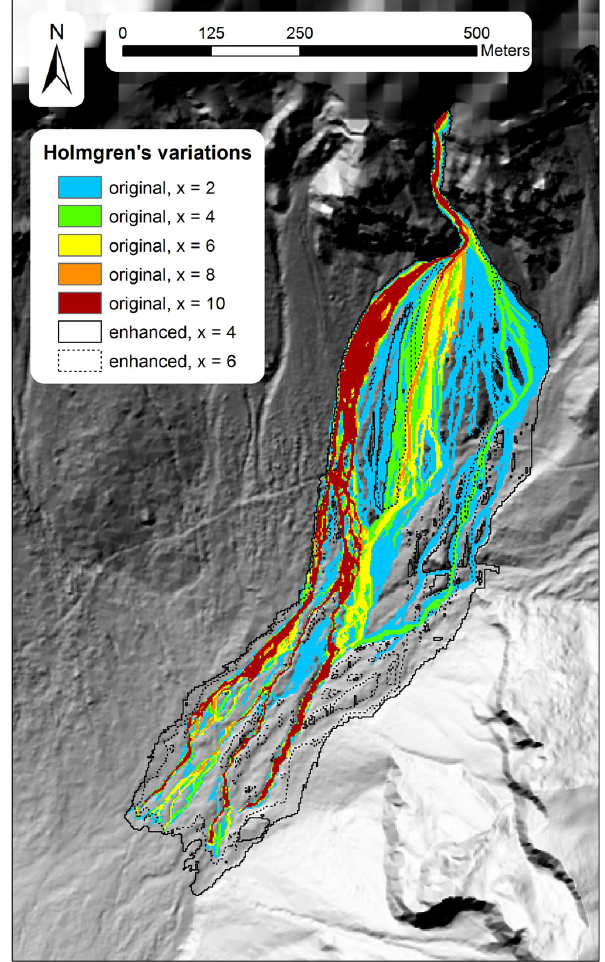
Fig. 12. Effect of the Holmgren’s exponent and the improvement of Holmgren’s spreading algorithm on a debris flow fan in Solalex, Switzerland (Geodata ©swisstopo – DV084371).